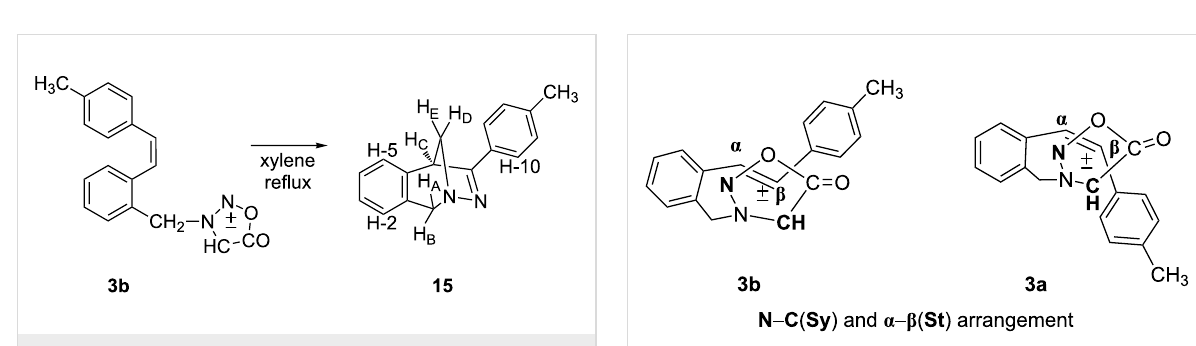
Scheme 7: Thermal reaction of cis - 3 .